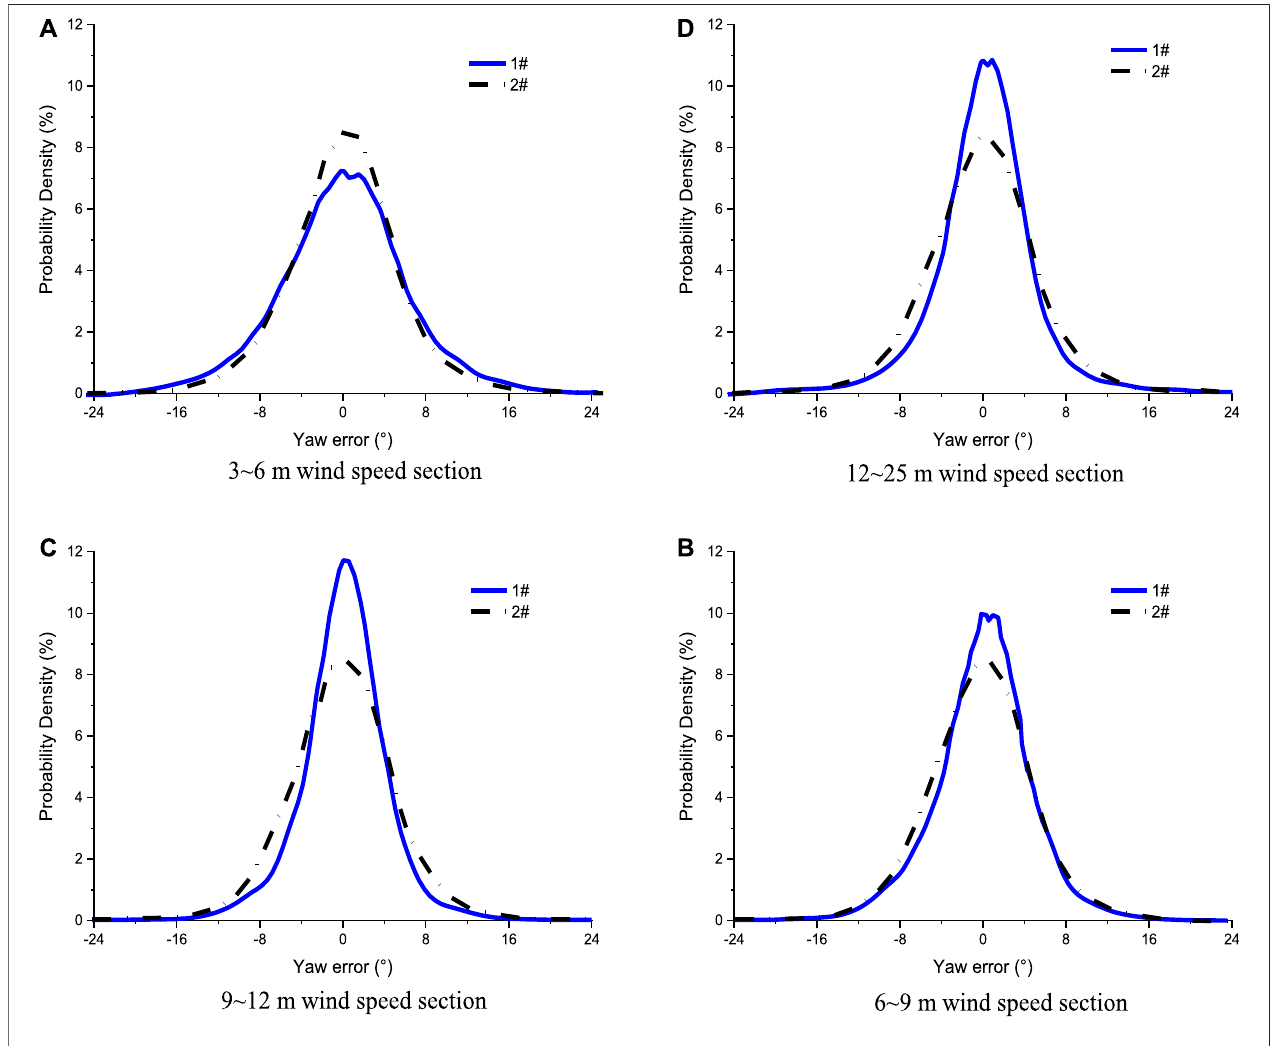
FIGURE 8 | Probability distribution of wind error in different wind speed